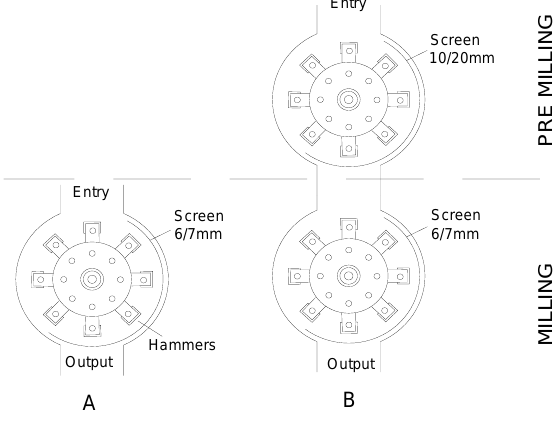
Fig. 3. Hammer mill principle scheme.